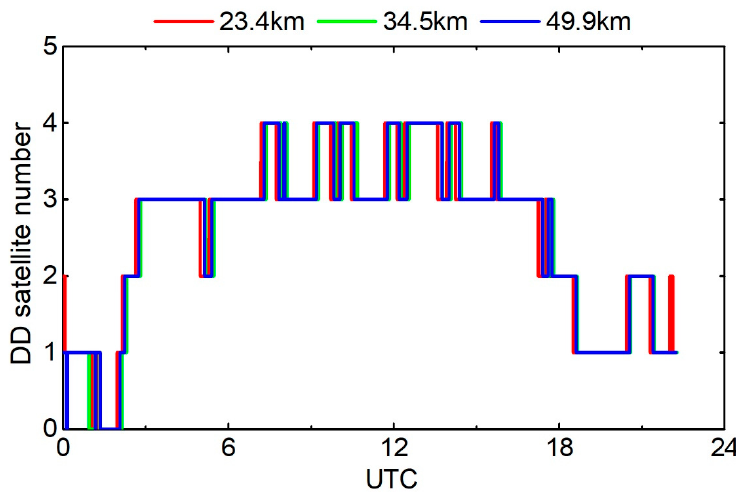
Figure 6. The number of GPS DD satellite pairs in three baselines. The same strategy was adopted in GPS TCAR, and three arbitrary DD satellite pairs (G10–G24, G32–G10, G03–G01) were chosen to illustrate the performance of GPS triple- frequency data by two TCAR methods. The residual of ∆ ∇ N ( elevation angle are shown in Figure 7; the result of GPS is similar to that of Galileo in Figure 3; both systems could use the HMW combination to determine ∆ ∇ N ( in a single epoch.